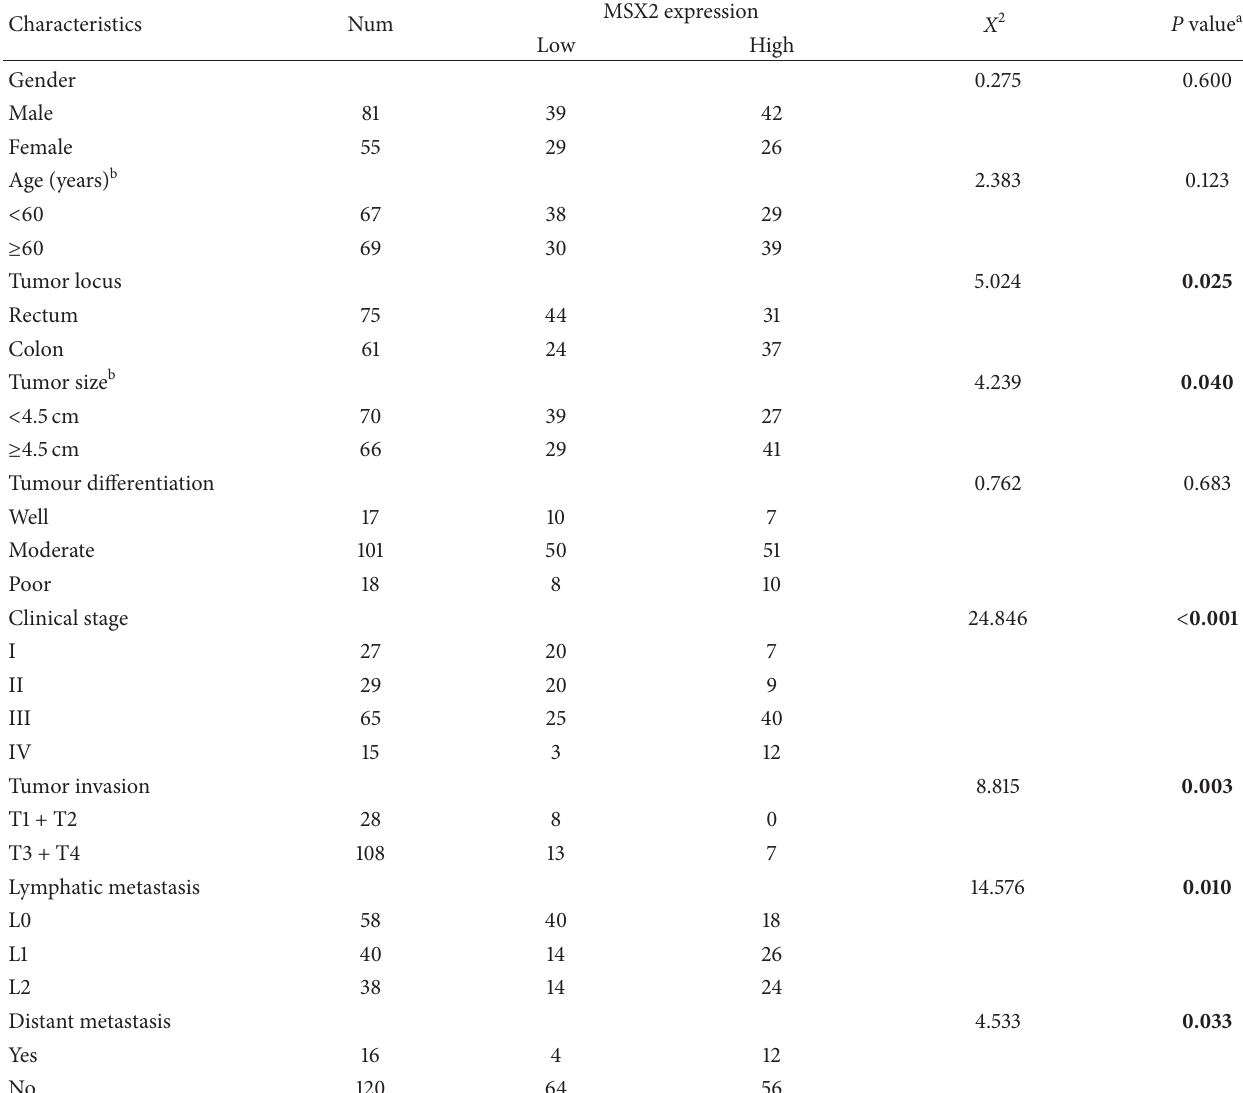
Table 1: Relationship between the MSX2 expression and clinicopathological characteristics of